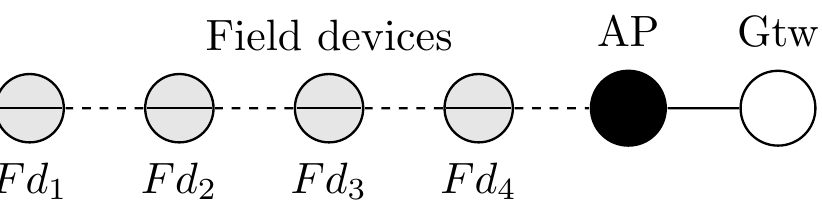
Figure 17. Typical line topology for a WSN.